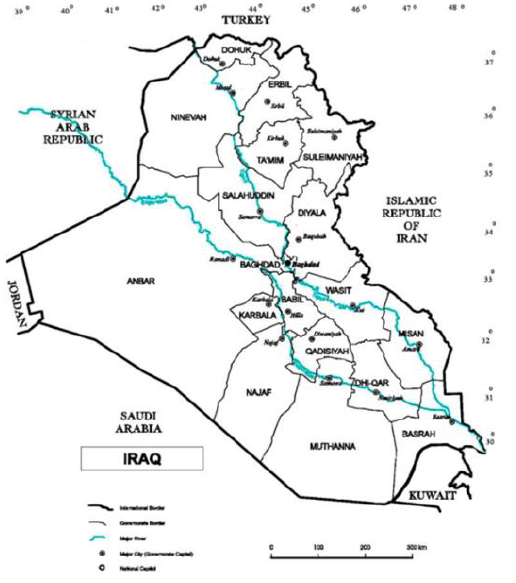
Figure 1: The location of Iraq and the neighboring